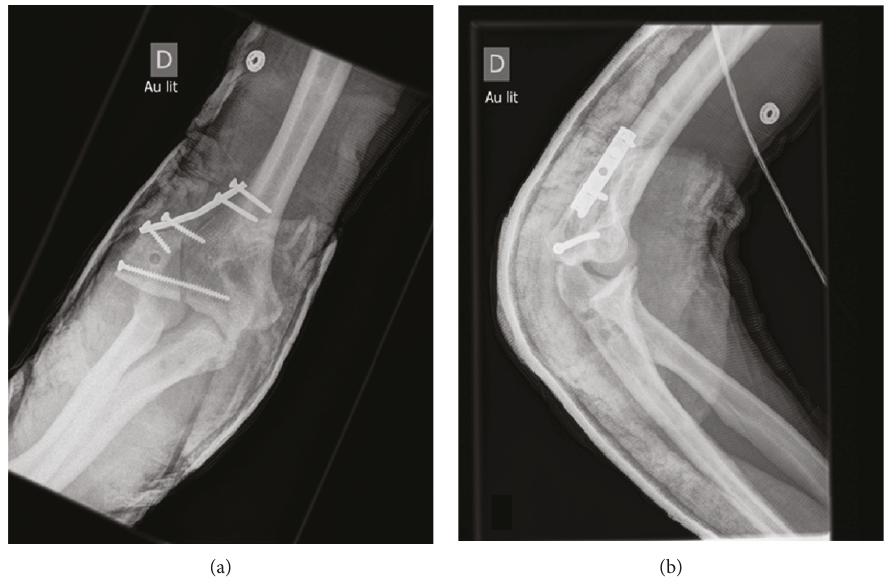
Figure 3: (a) Anteroposterior and (B) lateral 14 days postoperative X-rays of the right elbow.